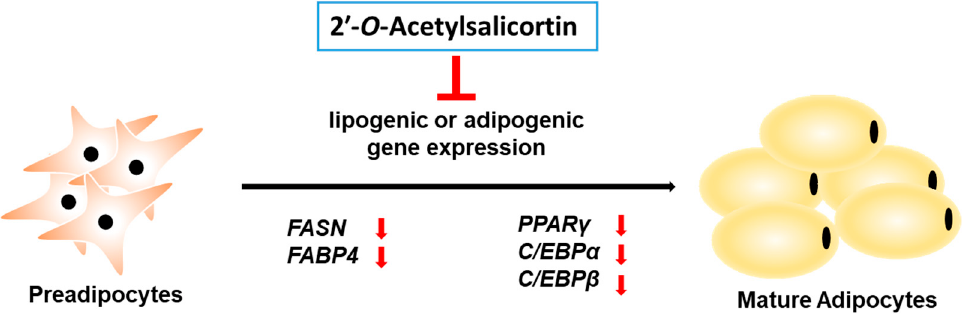
Figure 5. The model on the action of the 2 ′ - O -acetylsalicortin in 3T3-L1 differentiation. 2 ′ - O -acetylsalicortin represses adipocyte differentiation through the downregulation of mRNA and proteins of lipogenic enzymes and adipogenic factors.